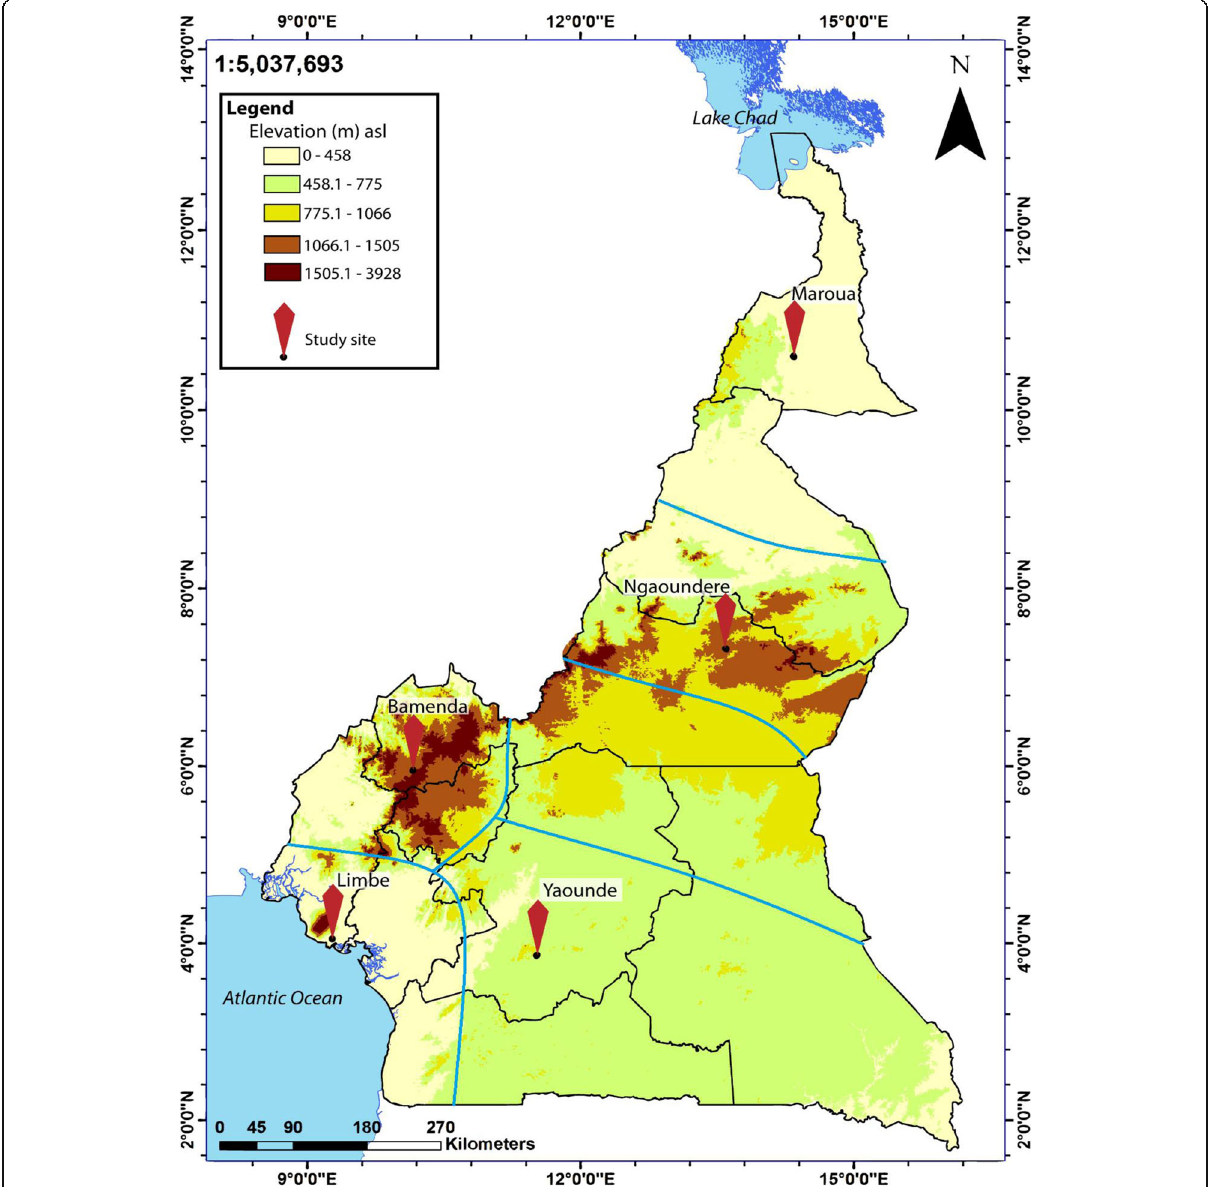
Fig. 1 Map depicting the study sites selected. Five epidemiological strata are